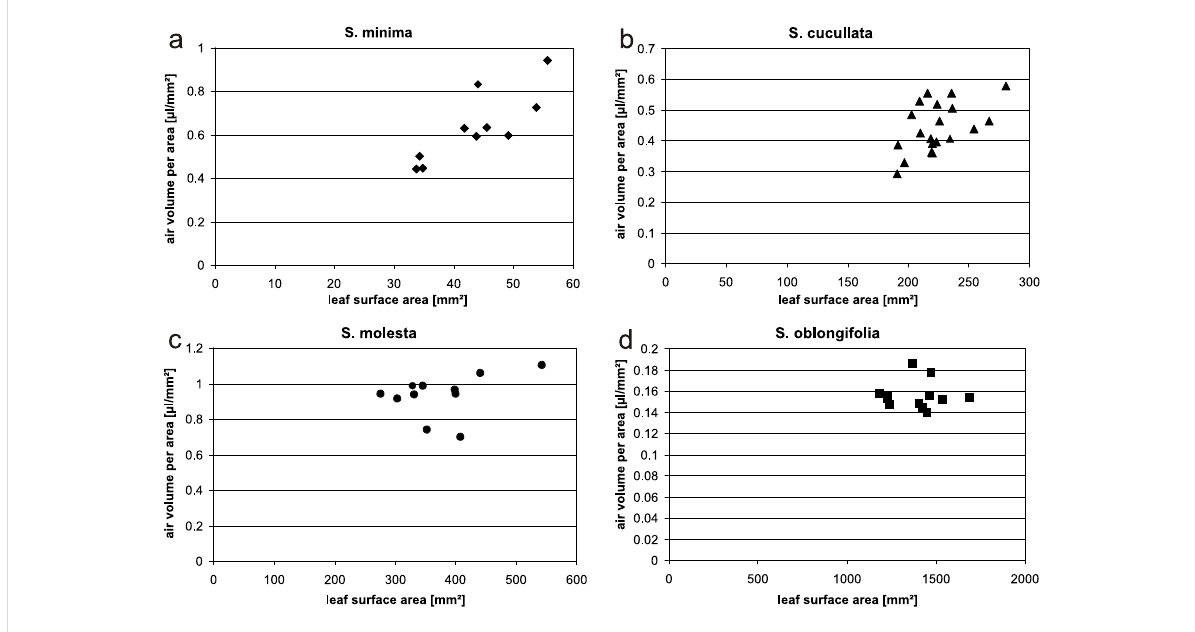
Figure 2: Air volume per surface area measured on four different Salvinia species. a) S. minima ( n = 10), b) S. cucullata ( n = 19), c) S. molesta ( n = 11), d) S. oblongifolia ( n =